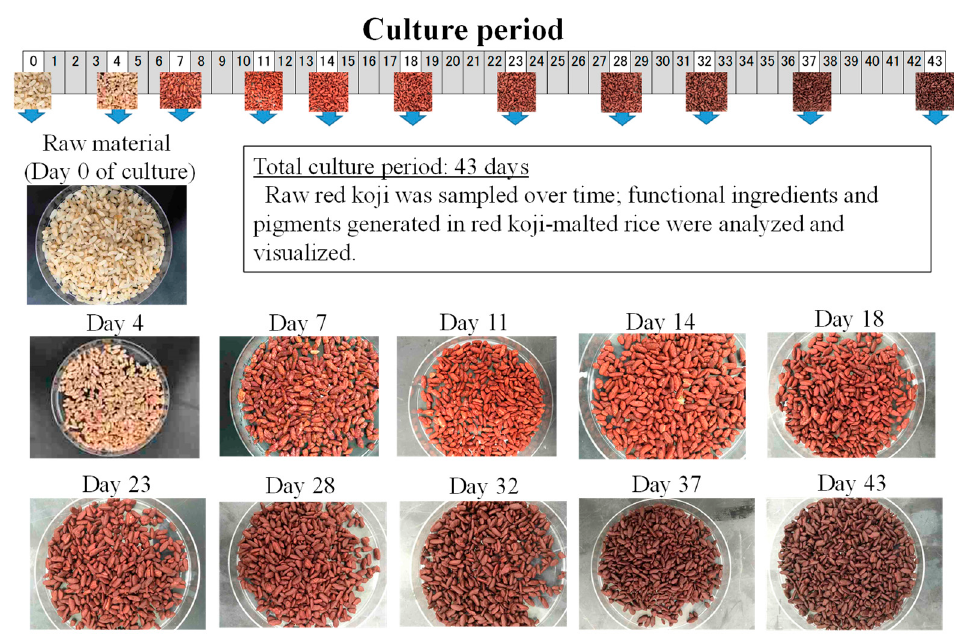
Figure 8. Time course change in appearance of red koji , which reddens during fermentation.